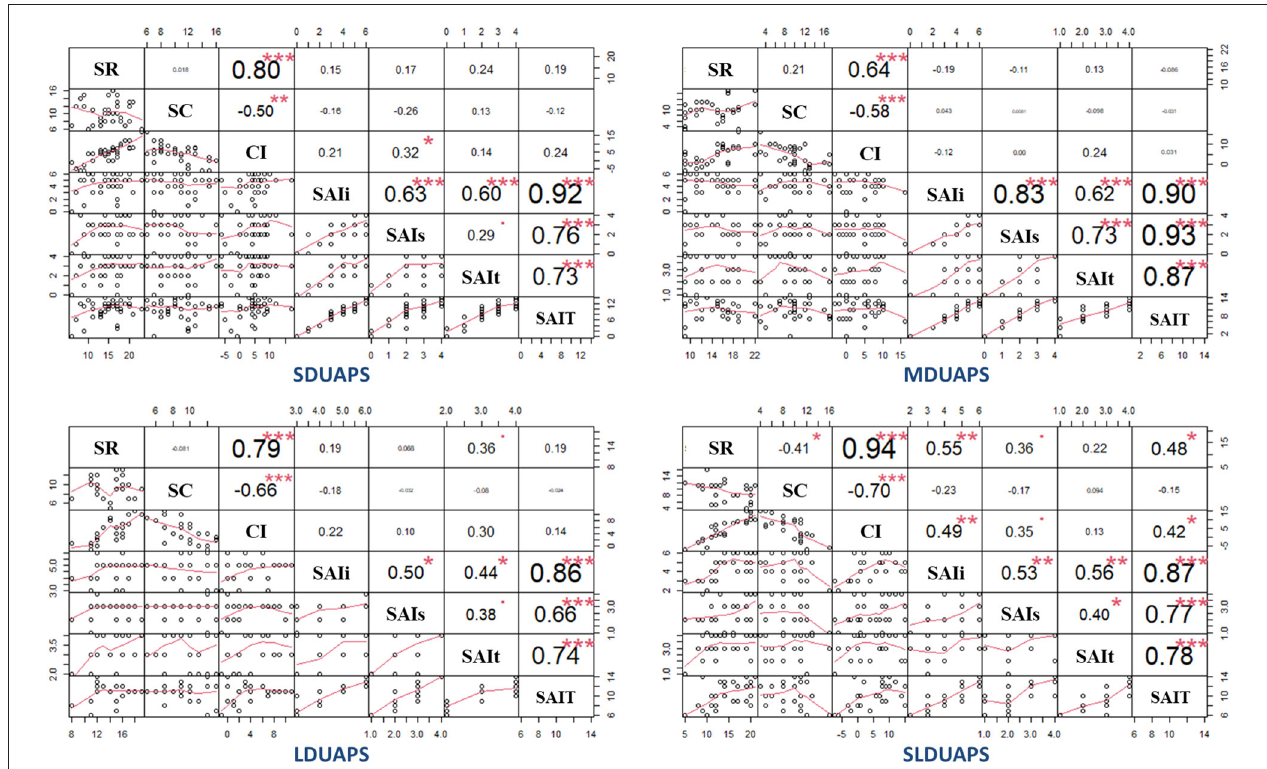
FIGURE 2 | Correlation (Spearman) between cognitive and clinical insight. DUAPS is the duration from the onset of prodromal symptoms to the first visit to seek professional help; SDUAPS, MDUAPS, LDUAPS, and SLDUAPS refer to 0–3, 4–6, 7–12, and > 12 months, respectively; SR refers to self-reflectiveness; SC refers to self-certainty; CI refers to composite index; SAI is short for the schedule of assessment of insight; SAIi refers to the dimension of awareness into illness; SAIs refers to relabeling of specific symptoms; SAIt refers to treatment compliance; SAIT refers to the total score of SAI; * p < 0.05; ** p < 0.01; *** p <